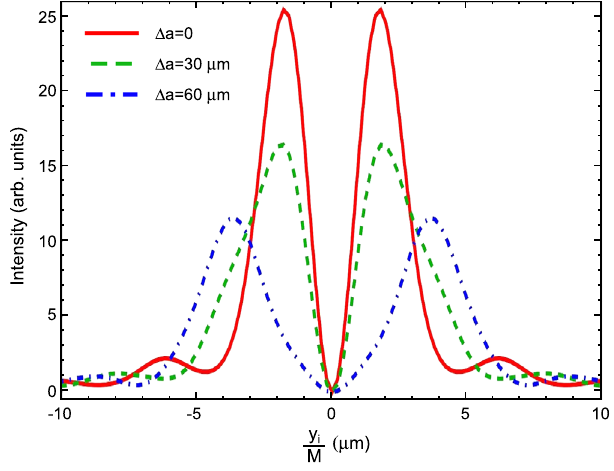
FIG. 2. Calculated OTR SPFs according to Eqs. (7) – (9). The parameter set for the calculation is indicated in the